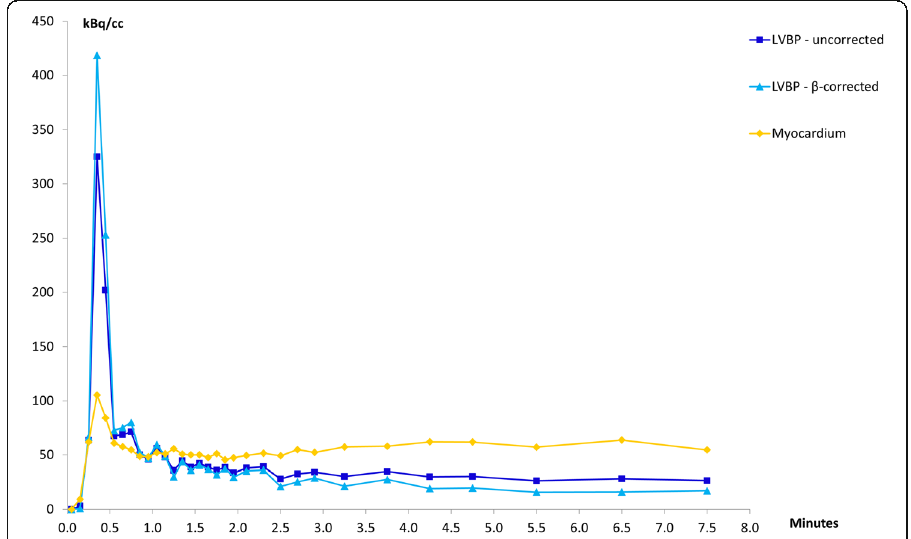
Fig. 6 Representative time activity curves from the left ventricular blood pool and the myocardium from one of the study